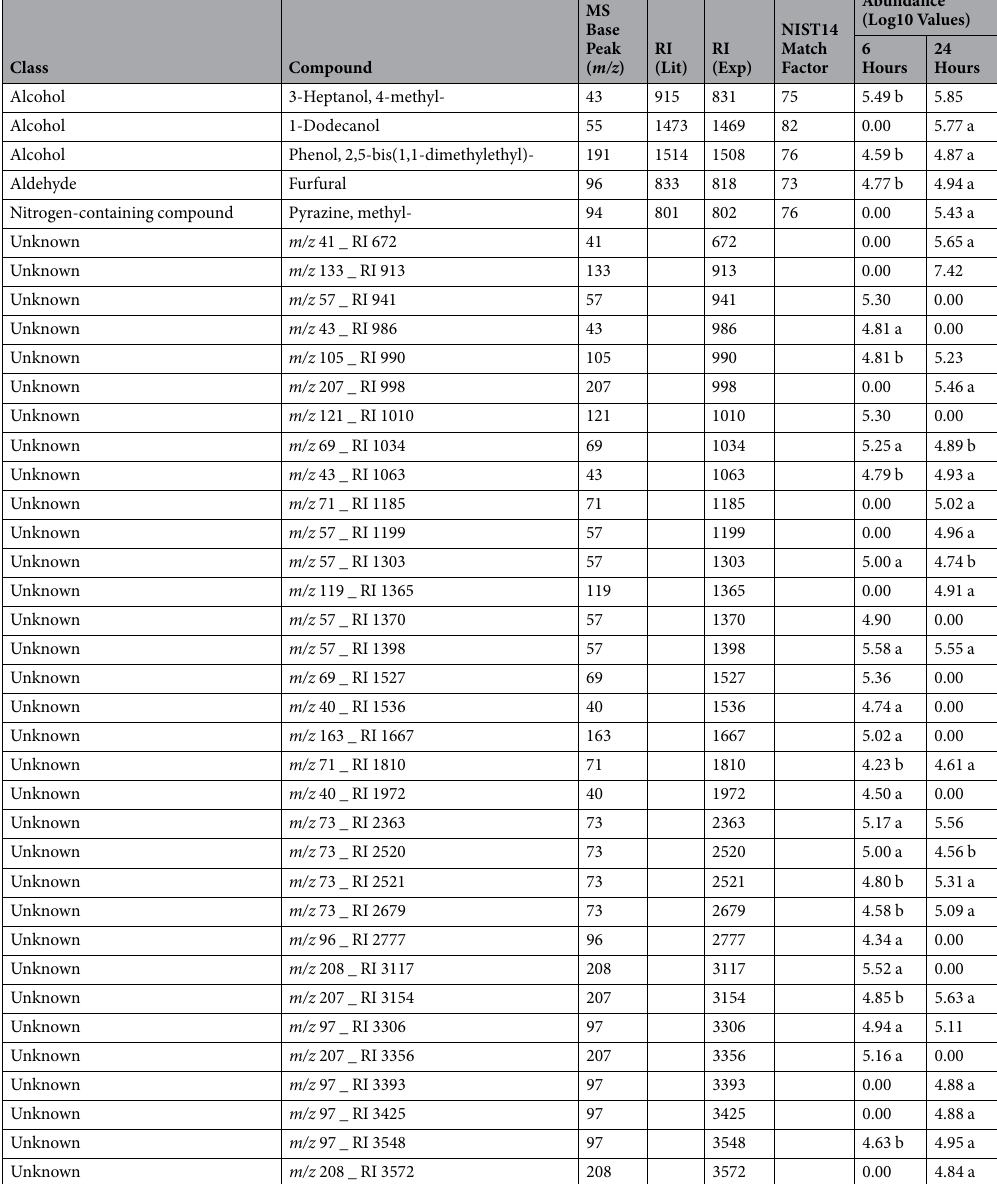
Table 6. Annotations of F. tularensis SCHU S4-specific VOC markers and average relative abundances (n = 3) at 6 and 24 hours post inoculation. Notes: a VOC detected in 2/3 of triplicate measurements b VOC detected in 1/3 of triplicate measurements RI (Lit): Retention Index reported from NIST14 RI (Exp): Retention Index calculated from